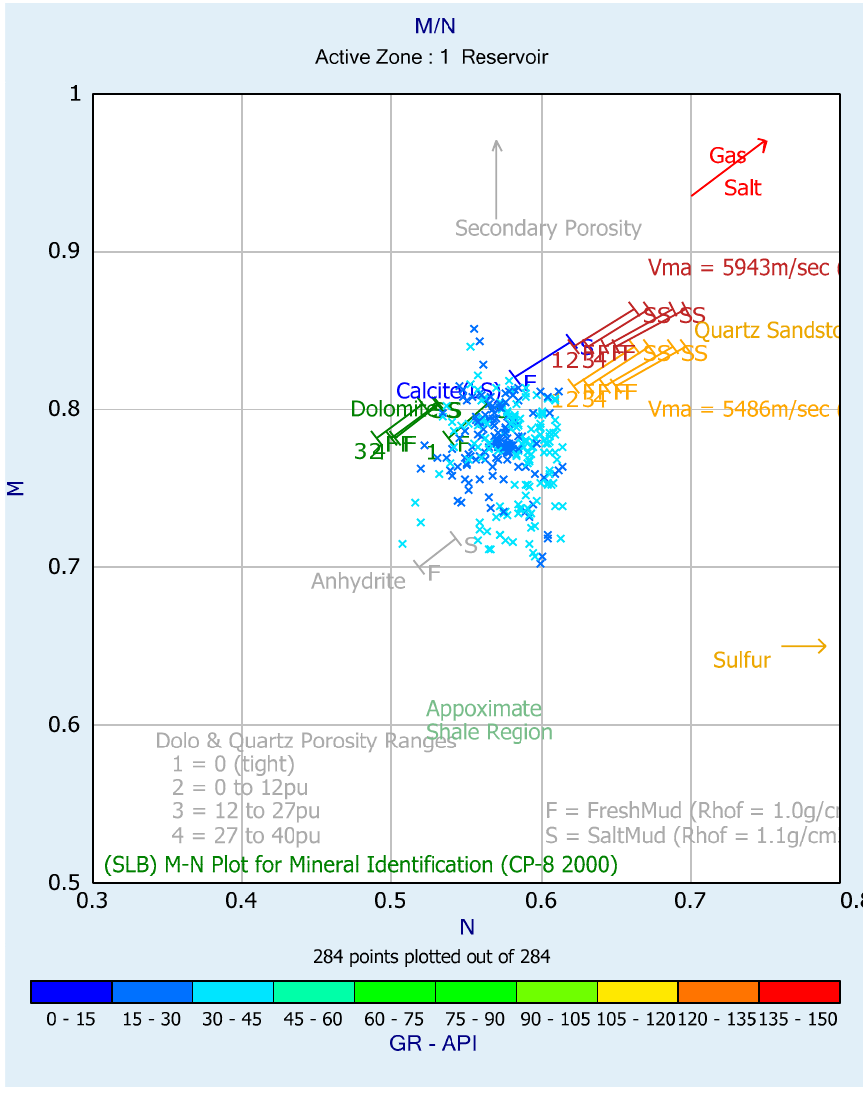
Figure 6. QGF well 03 M and N cross-plot of reservoir zones.